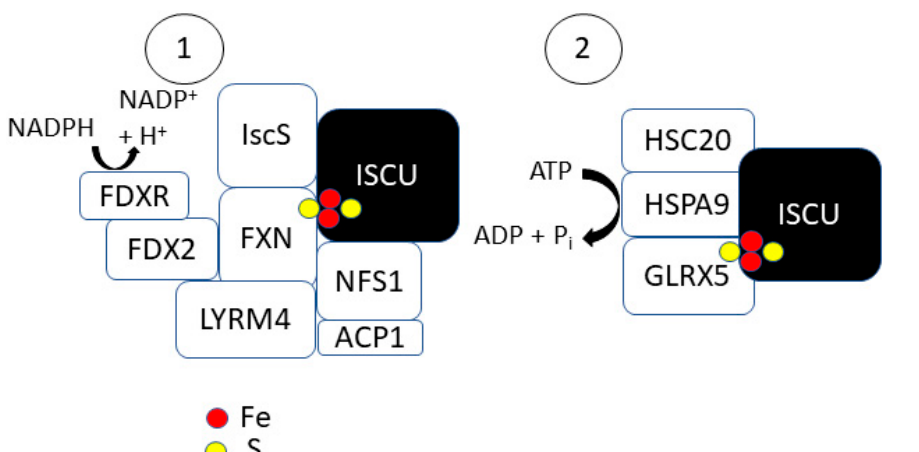
Figure 2. Factors involved in [2Fe-2S] cluster formation and transfer by the scaffold protein, ISCU. (1). Initial cluster formation occurs on ISCU with sulfur donation occurring by the cysteine desul- furases, NFS1/IscS (in prokaryotes). Frataxin binds at the interface of ISCU and NFS1 to allow for access to the PLP site to allow for persulfide transfer to ISCU. FXN facilitates this process. LYRM4 and ACP1 enhanceS complex stability. (2). Following completion of the [2Fe-2S] cluster on ISCU, an ISCU[2Fe-2S]-HSC20-HSPA9 complex is formed that facilitates the ATPase activity of HSPA9 allowing for [2Fe-2S] transfer to GLRX5. GLRX5 can rapidly transfer the [2Fe-2S] cluster to target proteins.